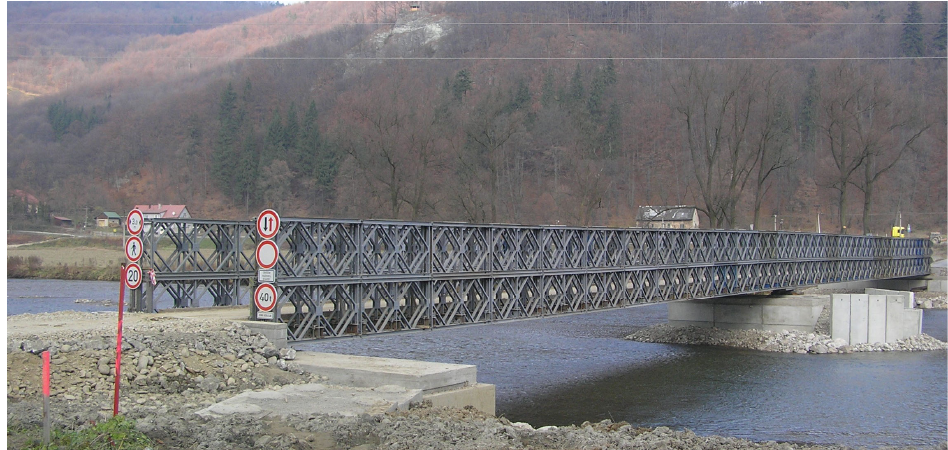
Figure 2. Bailey bridge (TD ‐ 36 + 36) placed on construction site road over Orava river (Slovakia).